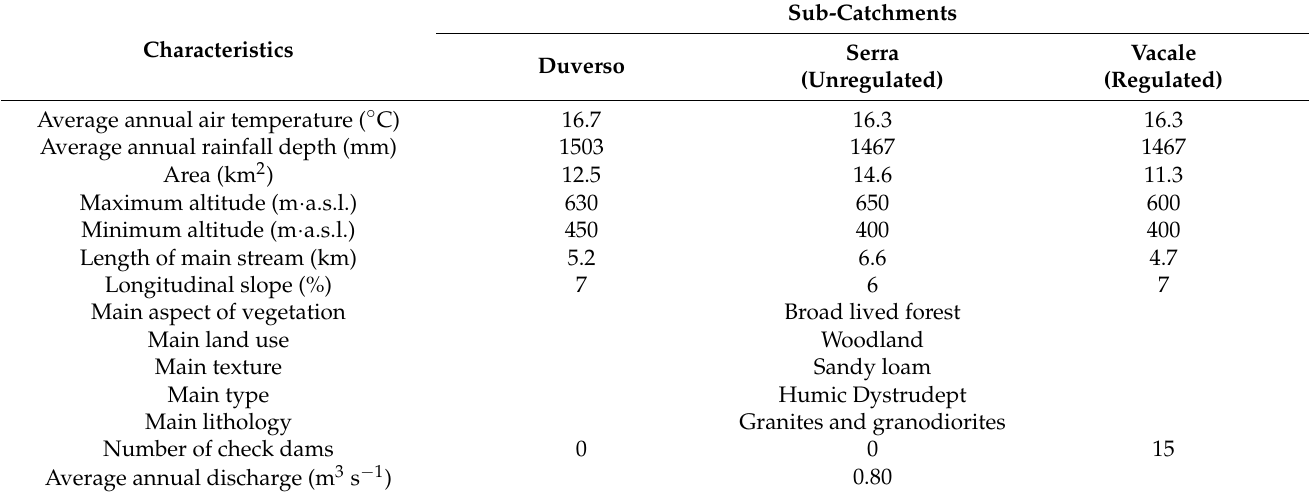
Table 1. Main characteristics of the selected sub-catchments (Calabria, Southern